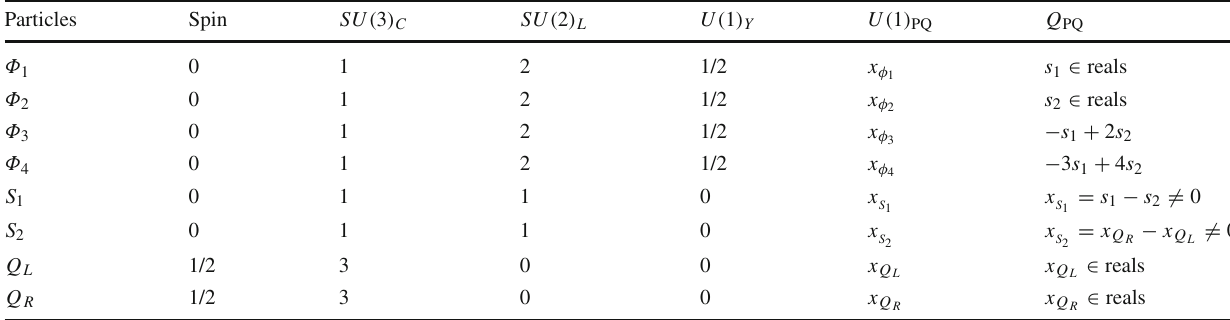
Table 2 Beyond SM scalar and fermion fields and their respective PQ charges. The parameters s 1 , s 2 are reals, with s 1 (cid:9)= s 2